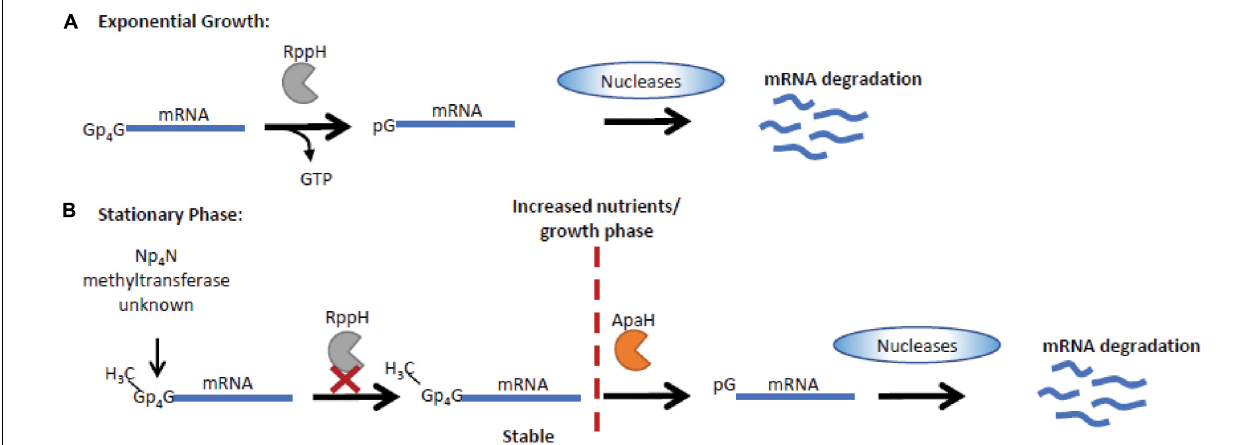
FIGURE 2 | Np 4 N regulates transcript stability in stationary phase in E. coli. (A) Np 4 N caps can be incorporated into mRNA during transcription initiation. During exponential growth, Np 4 N caps can be removed by RppH, generating an NTP and a 5 (cid:48) p-terminus on the mRNA, which is then degraded by the RNase E endonuclease (Luciano et al., 2019). (B) In stationary phase, methylation of the Np 4 N caps increases their stability as RppH is unable to process methyl-Np 4 N-caps. The processing of methyl-Np 4 N-caps is mediated by ApaH that is downregulated during stationary phase, increasing methyl-Np 4 N-mRNA stability (Hudeˇcek et al., 2020). Under conditions where growth can resume, ApaH is activated, promoting cleavage of methylated caps, resulting in mRNA with a 5 (cid:48) p-terminus that is efficiently degraded by RNase E nucleases.